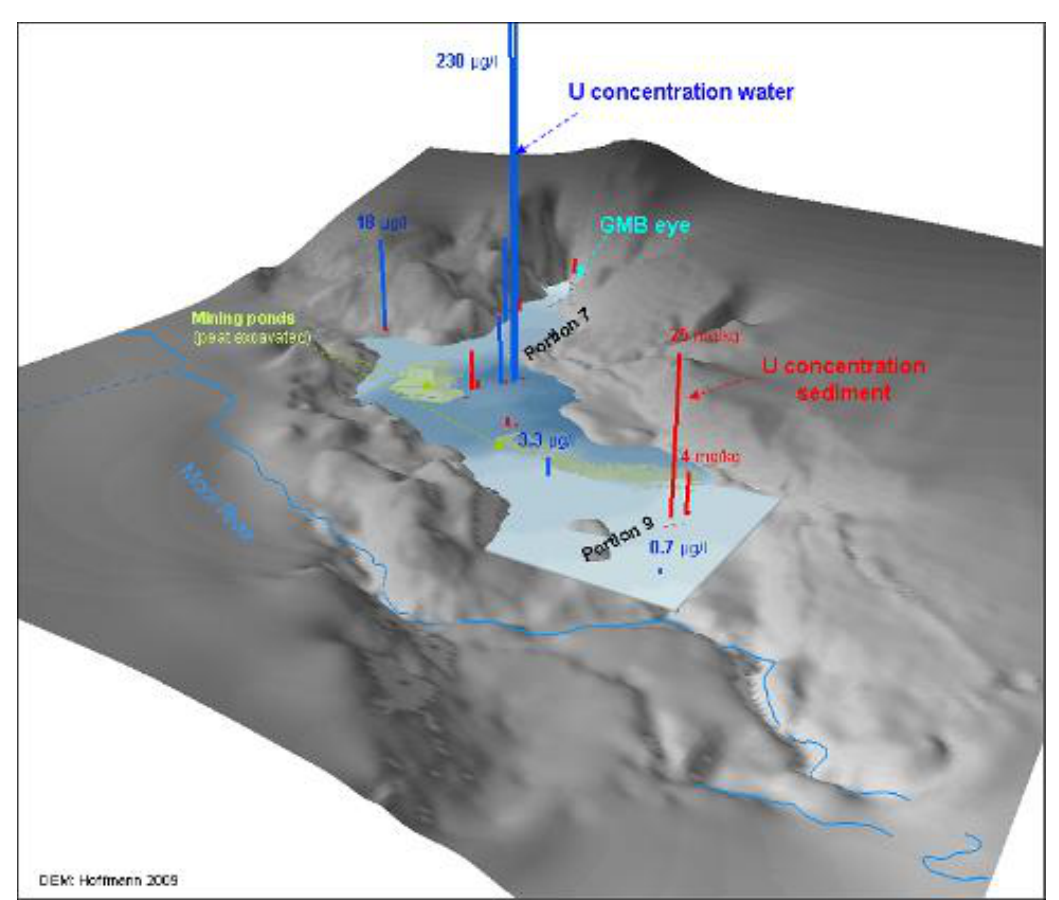
Figure 13. GIS-extrapolated U concentration in water of the GMB wetland in comparison to U levels in associated sediments (darker blue tones of the water indicate increasing U